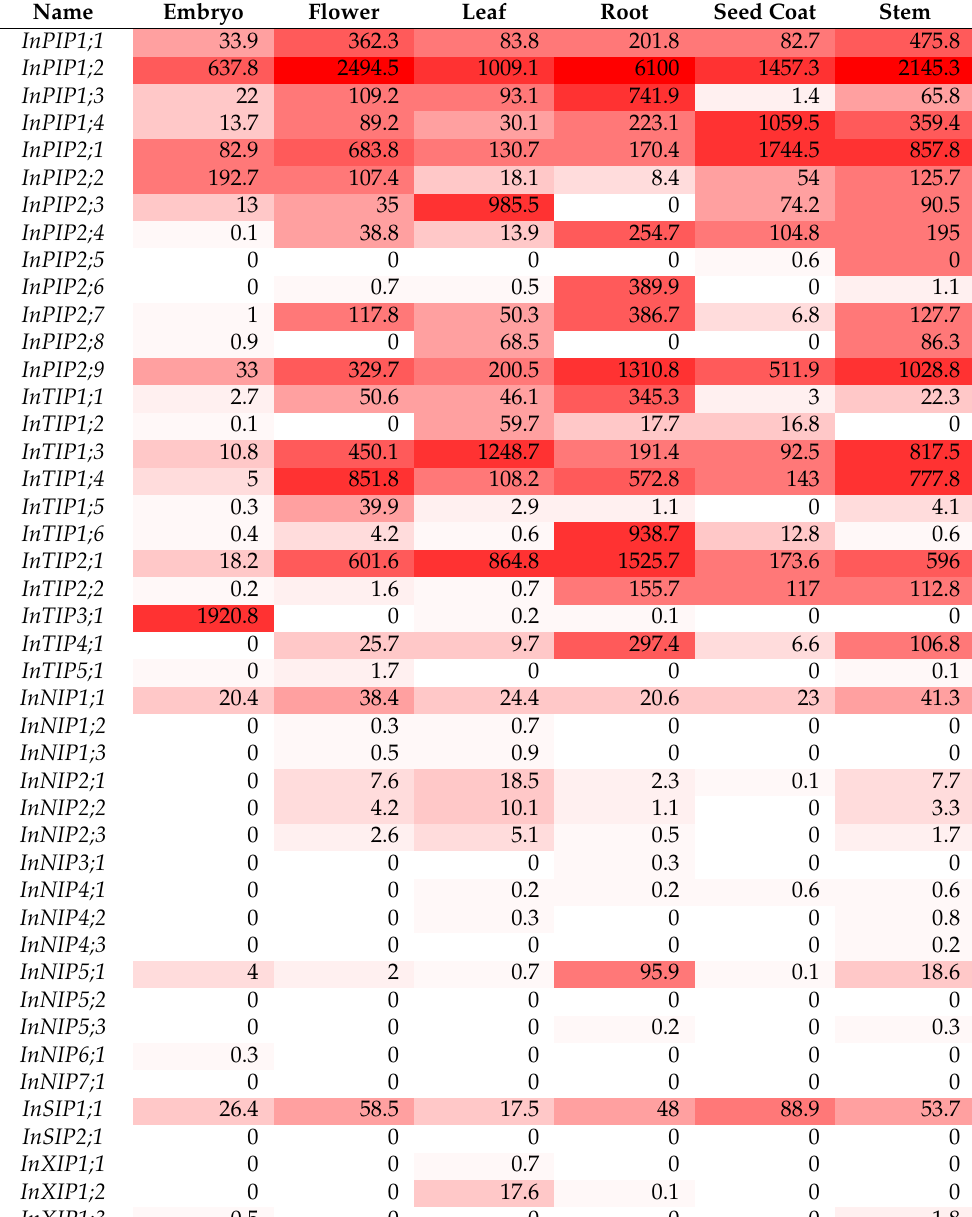
Table 3. Gene expression of AQPs in Japanese morning